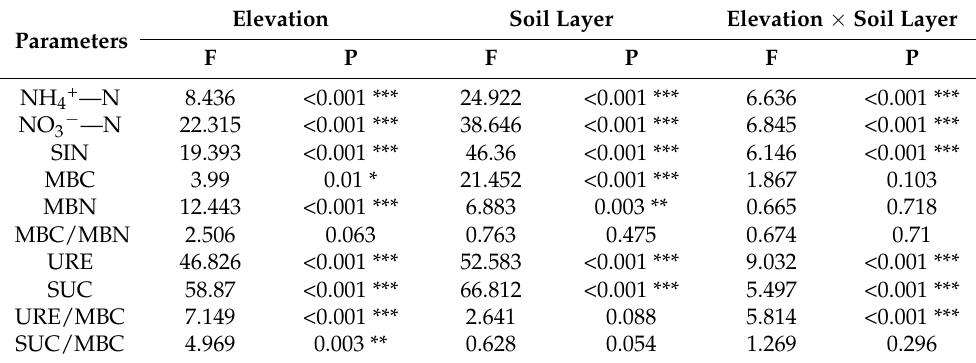
Table 4. Analysis of variance between the altitude and soil layer on active soil